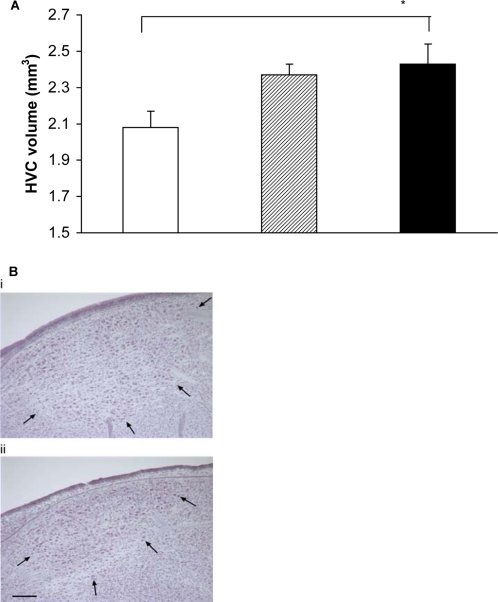
HVC size in male starlings exposed to chemicals.a) HVC volume (mean+s.e.m.) in the three treatment groups; control (open bars); E2 dosed (hatched bars); and the chemical mixture dosed (black bars) (ANOVA, F
2, 32 = 4.46, P = 0.019). HVC volume of the males in the mixture group was significantly larger than in males in the control group (Bonferroni pairwise comparison post-hoc tests P = 0.032), but there were no significant differences in the HVC volume between males in the E2 and control groups (P>0.05) or between males in the E2 and mixture groups (P>0.05) * = P<0.05. b) Photomicrograph of an HVC from (i) a chemical mixture treated male and (ii) a control male. Arrows indicate the borders of HVC. Scale bar = 200 µm.